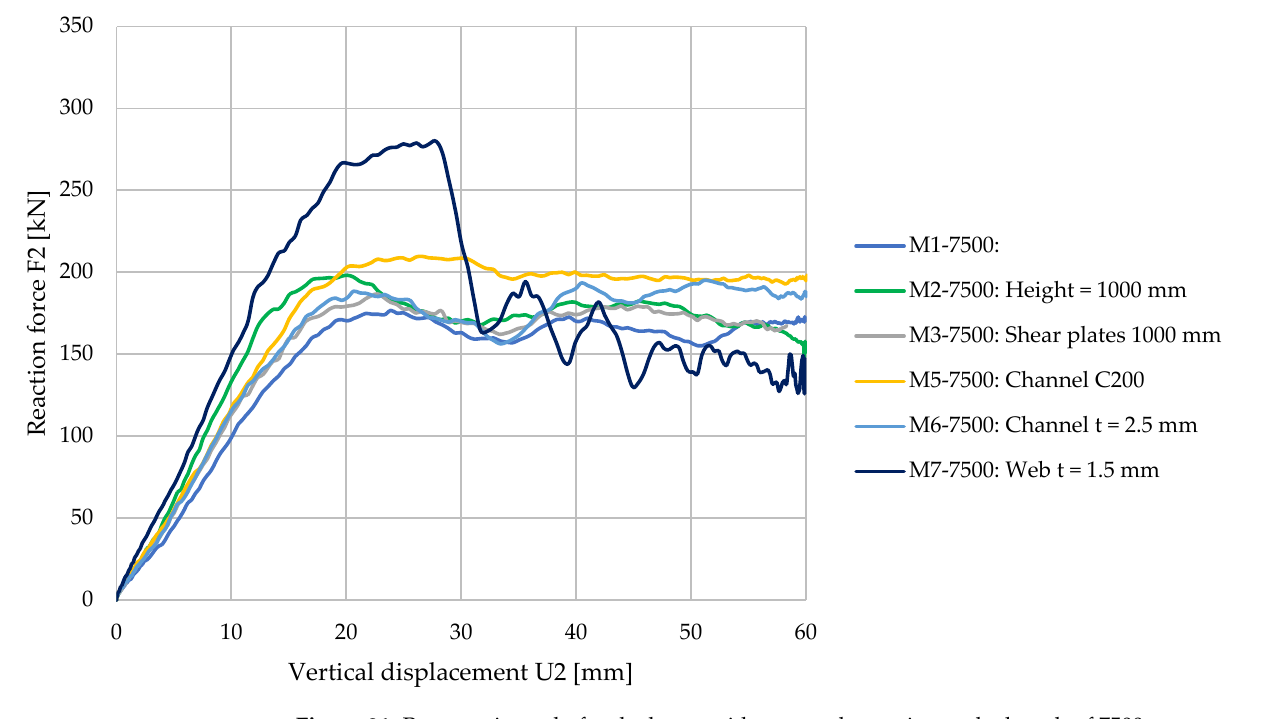
Figure 21. Parametric study for the beam without a web opening and a length of 7500 mm.